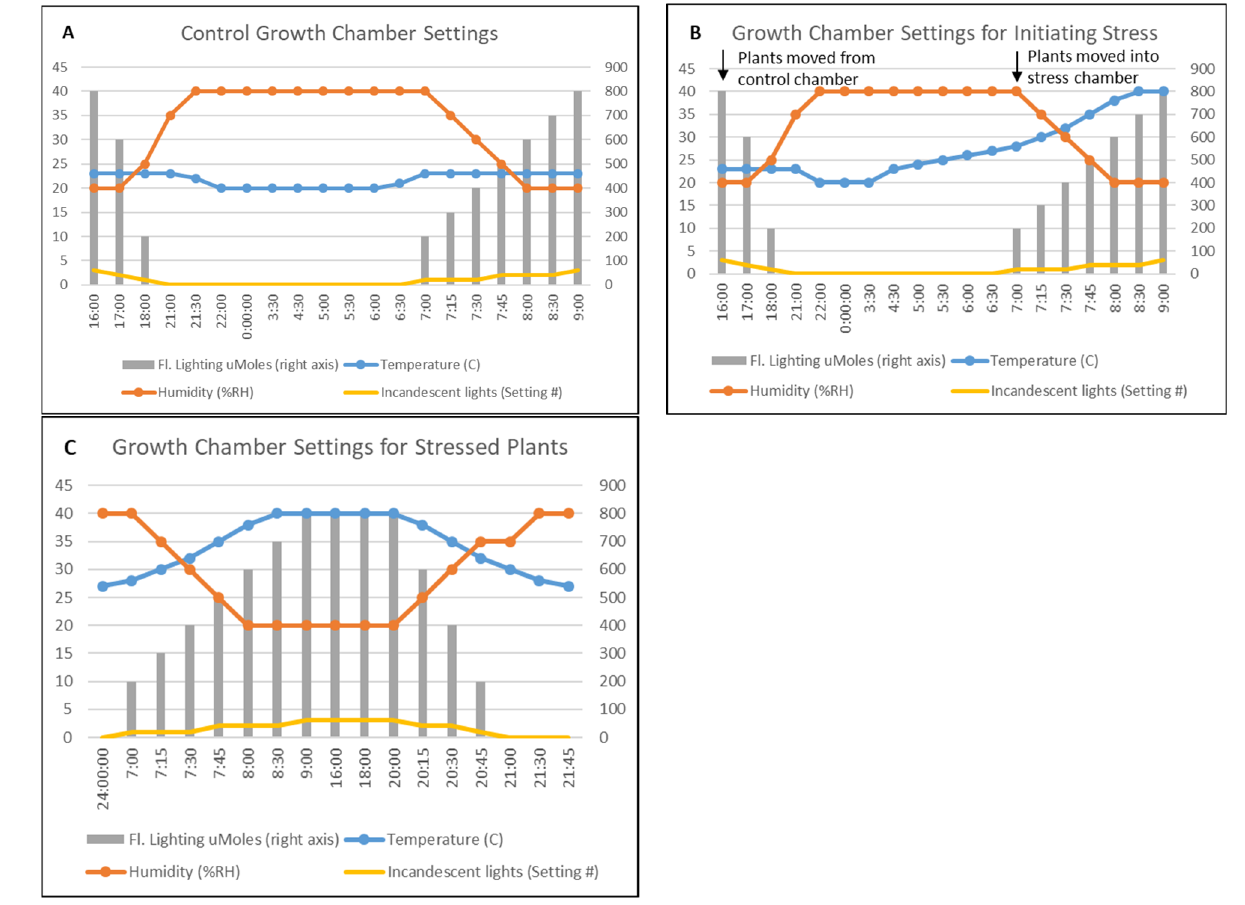
Figure 8. Growth chamber settings for experiments. The left axis numbers denote values for temperature in °C and the percent relative humidity (%RH). The right axis represent fluorescent lighting values in µMoles. Time of day is listed on the x-axis. ( A ) Control growth chamber settings, ( B ) Stress-initiation growth chamber settings. ( C ) Stress chamber settings.